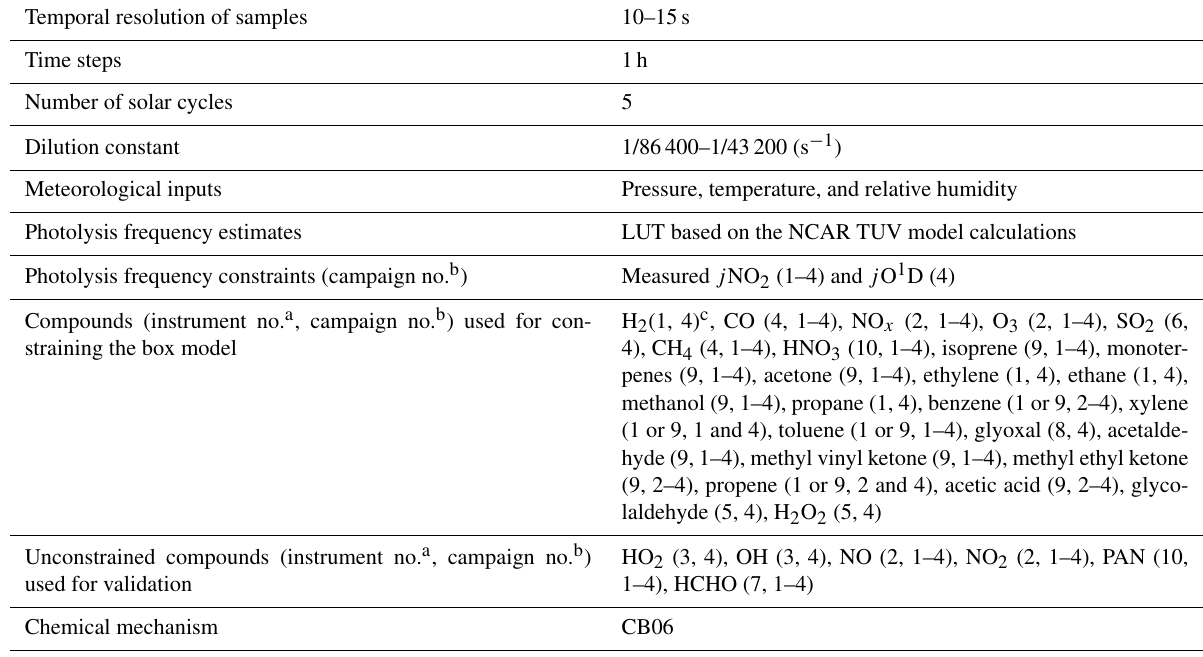
Table 1. The box model configurations and inputs. Temporal resolution of